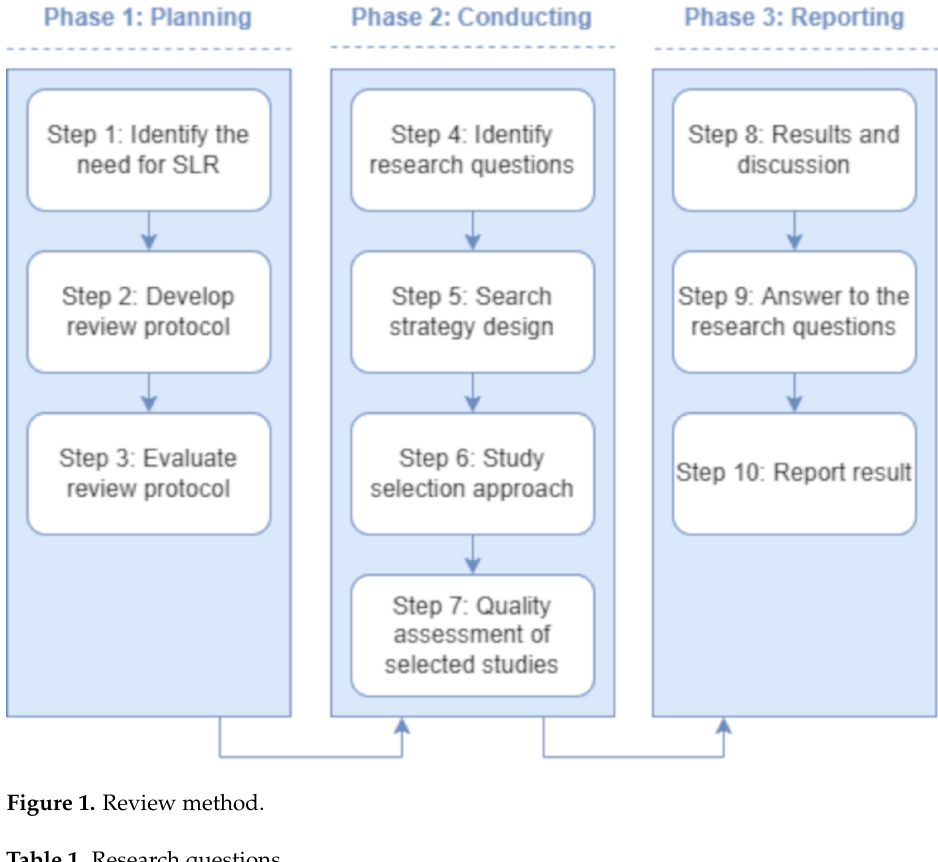
Figure 1. Review